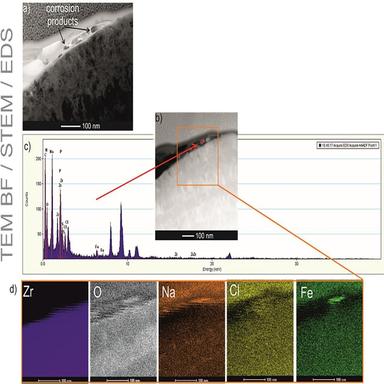
A cross-section image showing pitting corrosion in the Zr/Zr2N (1:4 ratio) multilayer coating performed by TEM; a) TEM BF image; and b) higher magnification of the image shown in a).